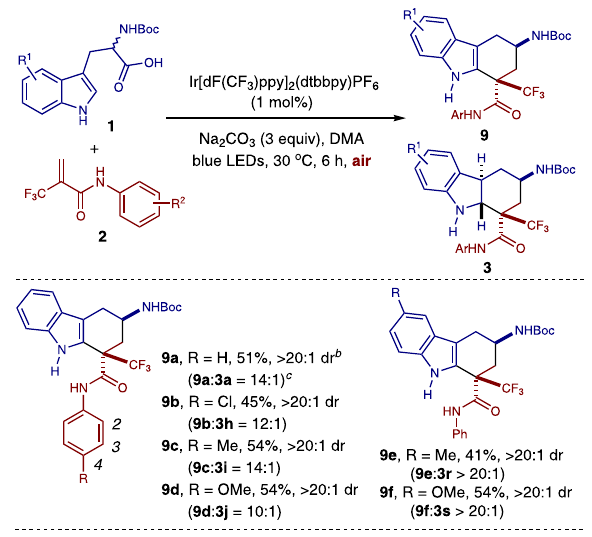
Fig. 4 Syntheses of tetrahydrocarbazoles. a Reaction conditions: 1 mol% of Ir[dF(CF 3 )ppy] 2 (dtbbpy)PF 6 , 0.15 mmol of 1 , 0.1 mmol of 2 , and 0.3 mmol of Na 2 CO 3 in DMA (2.0 mL) for 6 h under blue LEDs irradiation at 30 °C. Isolated yields of compound 9 are reported. b The dr was determined by crude 1 H NMR analysis. c The ratio was determined by crude 1 H NMR analysis.